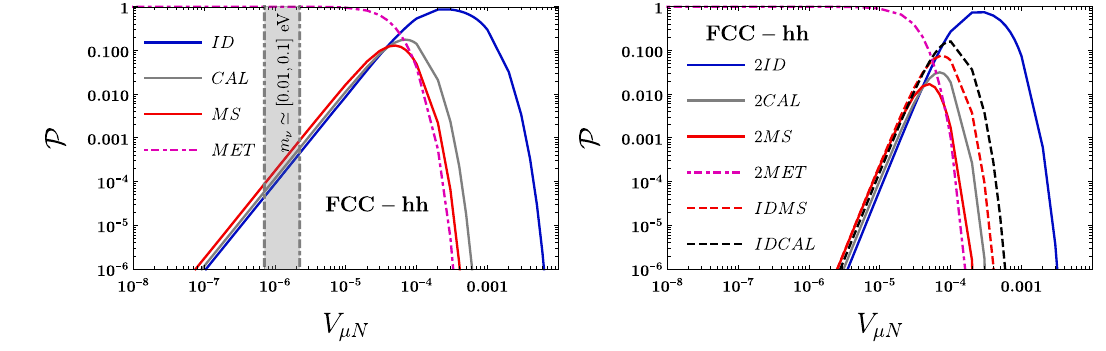
Fig. 7 As Fig. 6, but showing the decay probabilities for the FCC-hh with M N = 20 GeV and M Z (cid:2) = 8 TeV